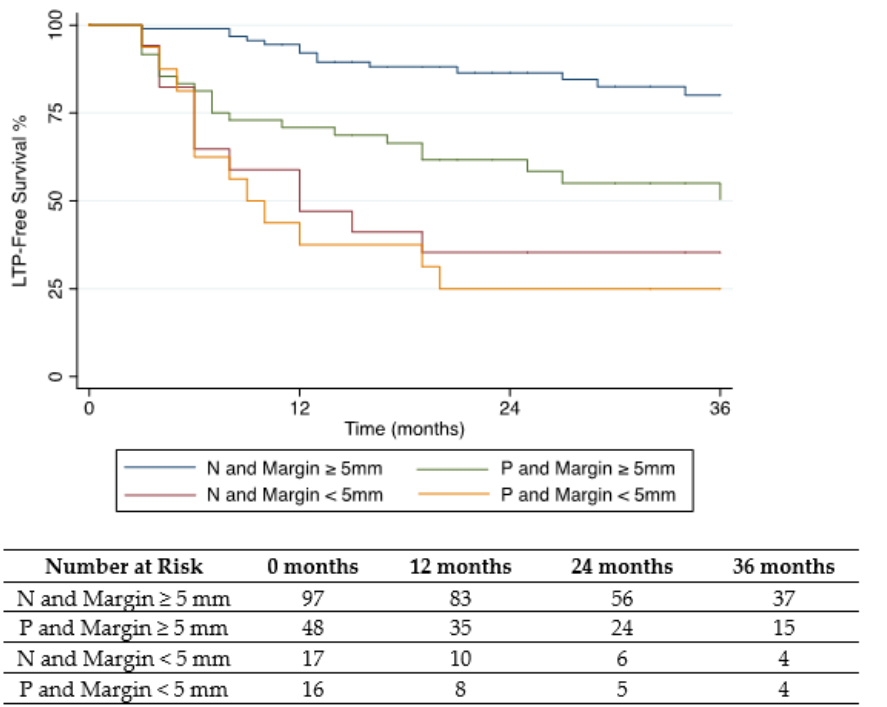
Figure 3. Cumulative incidence of local tumor progression over time stratified by post-ablation bi- opsy result (N: Negative or P: Positive) and ablation margin size. 3.4. Patient Survival Overall survival rate from the date of ablation was 92% (95% CI: 85, 96) at 12 months, 73% (95% CI: 64, 81) at 24 months, 56% (95% CI: 46, 65) at 36 months, and 35% (95% CI: 25, 45) at 5 years. The median OS from the date of ablation and from the date of initial